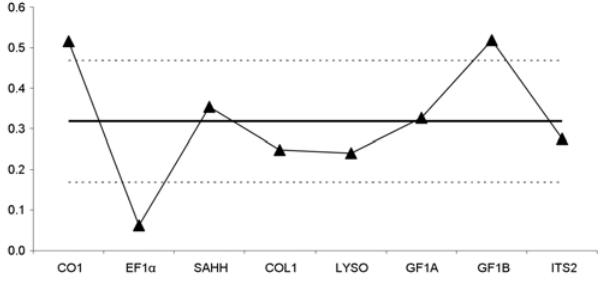
Figure 5. D azori/puteo /D ATL/PAC ratio for the 8 loci studied. The horizontal line represents the average divergence between the Atlantic and the Pacific. Doted lines correspond to the standard deviation.